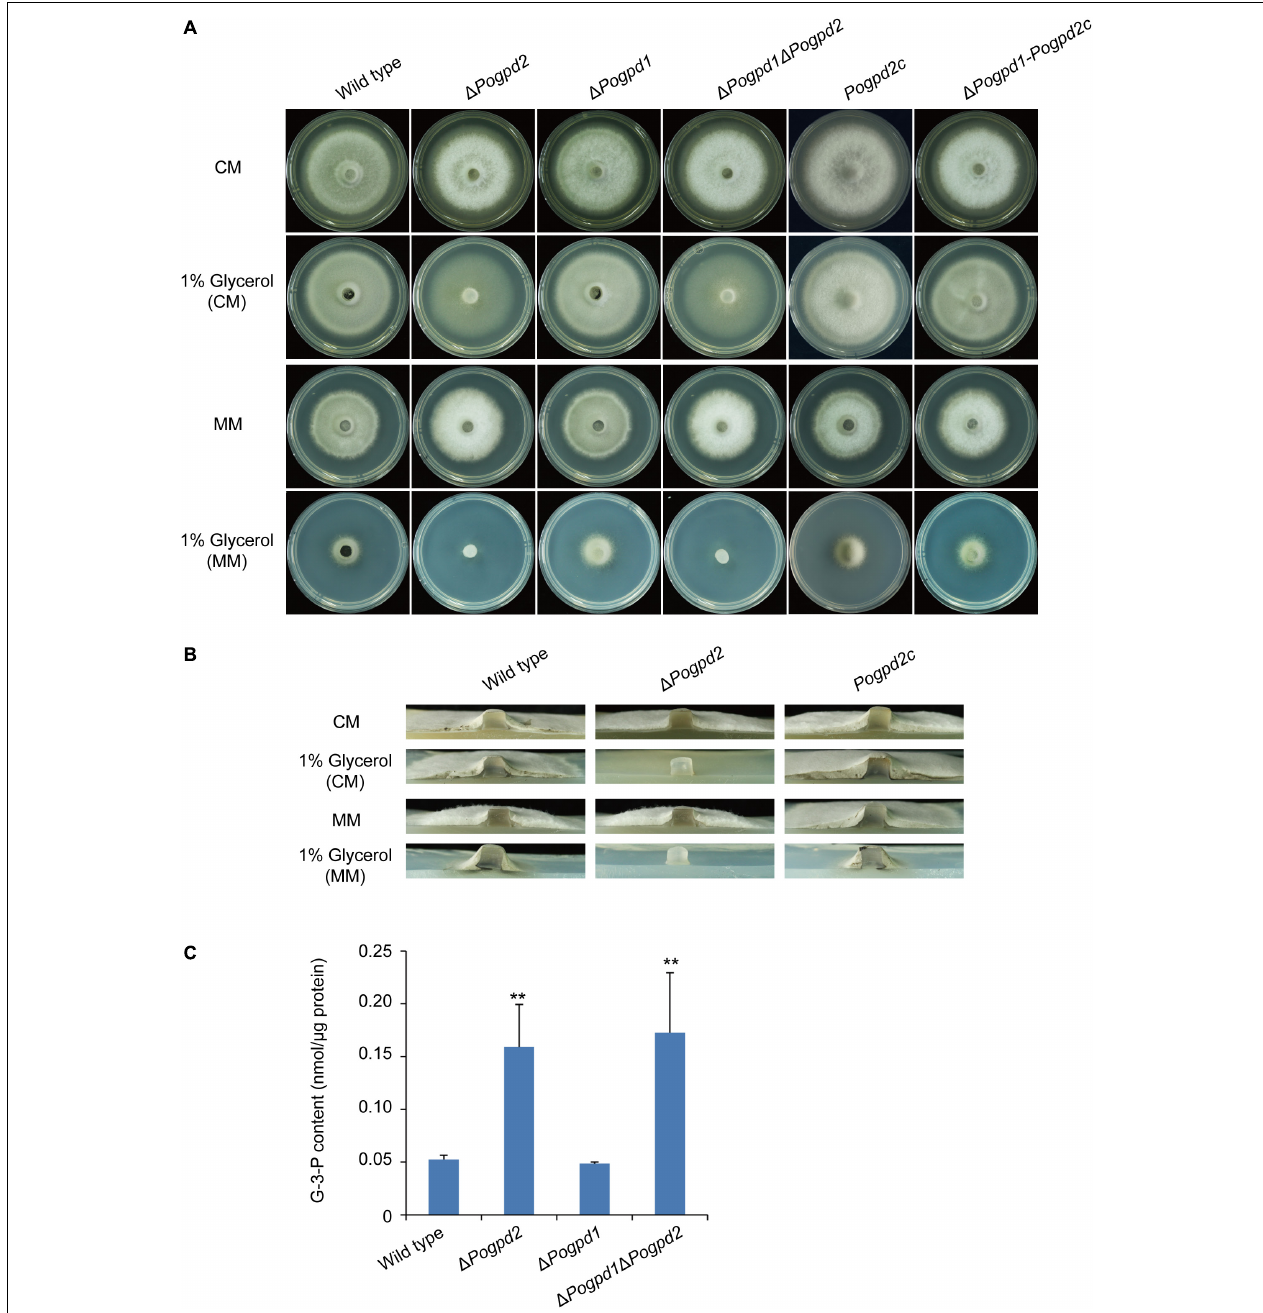
FIGURE 3 | Roles of glycerol-3-phosphate dehydrogenases in glycerol catabolism. (A) Mycelial colonies of the wild type, (cid:49) Pogpd1 , (cid:49) Pogpd2 , and (cid:49) Pogpd1 (cid:49) Pogpd2 , and the complementation strains Pogpd2c and (cid:49) Pogpd1 - Pogpd2c , grown on glycerol media for 8 days. (B) Aerial mycelia of the wild type, (cid:49) Pogpd2 , and its complementation strain Pogpd2c grown on glycerol media. (C) The glycerol-3-phosphate (G-3-P) content of aerial hyphal cells in the wild type, (cid:49) Pogpd1 , (cid:49) Pogpd2 , and (cid:49) Pogpd1 (cid:49) Pogpd2 cultured on CM medium. Error bars represent SD. Significant difference compared with the wild type as estimated by Tukey’s HSD test: ∗∗ P <